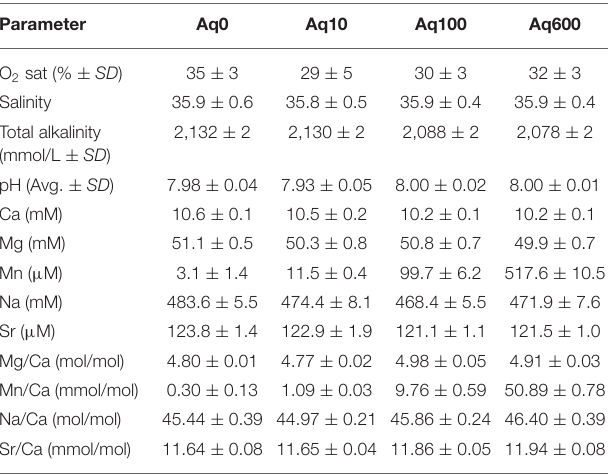
TABLE 1 | Culture parameters from the four different treatments (Aq0, Aq10, Aq100, and Aq600) used in the experiment.